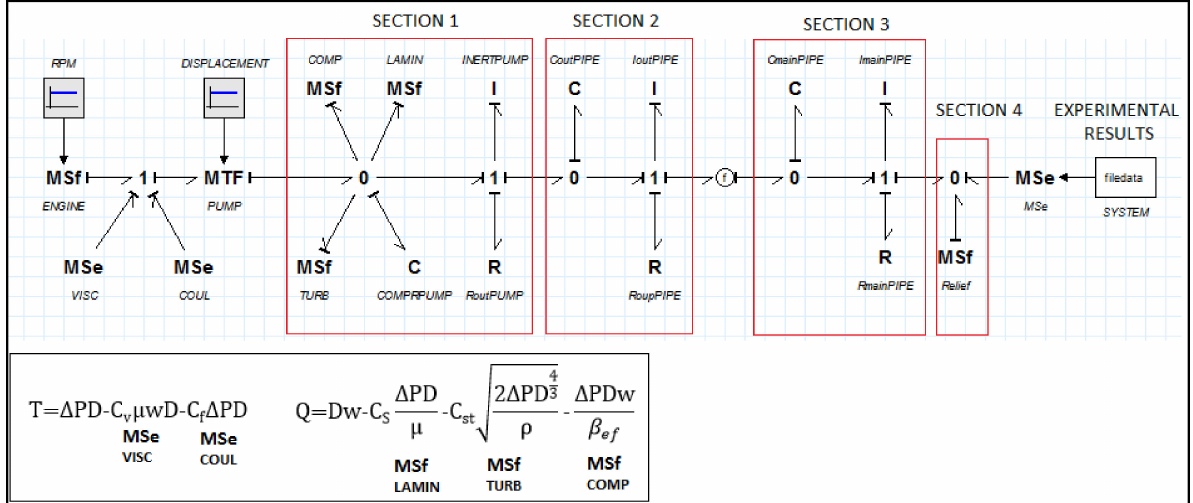
Figure 9. Simplified bond graph of the pump